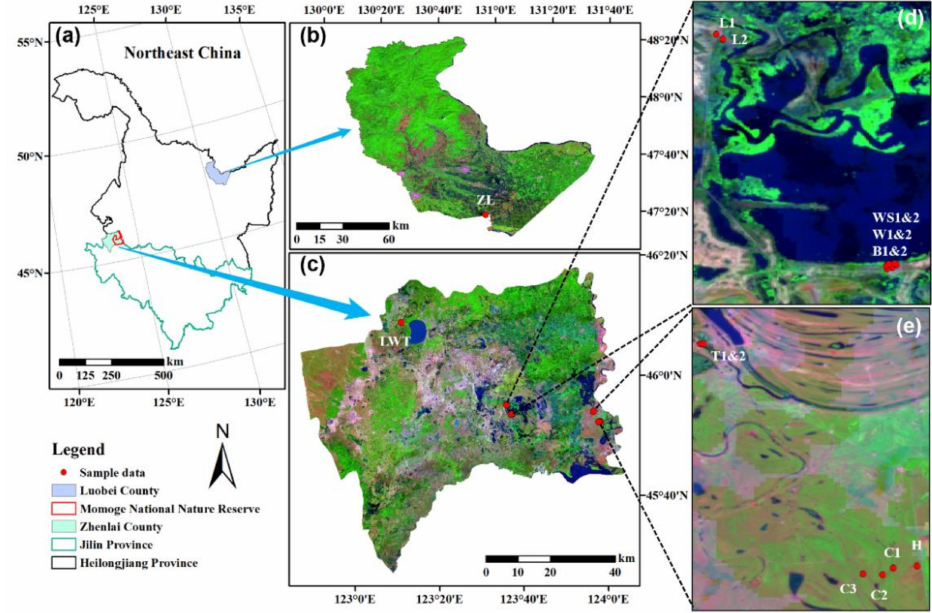
Figure 1. Location of the Momoge wetland in Zhenlai county and the Duluhe wetland in Luobei county ( a ). Remote sensing images from June 2017 of each sampling site are enlarged in ( b – e